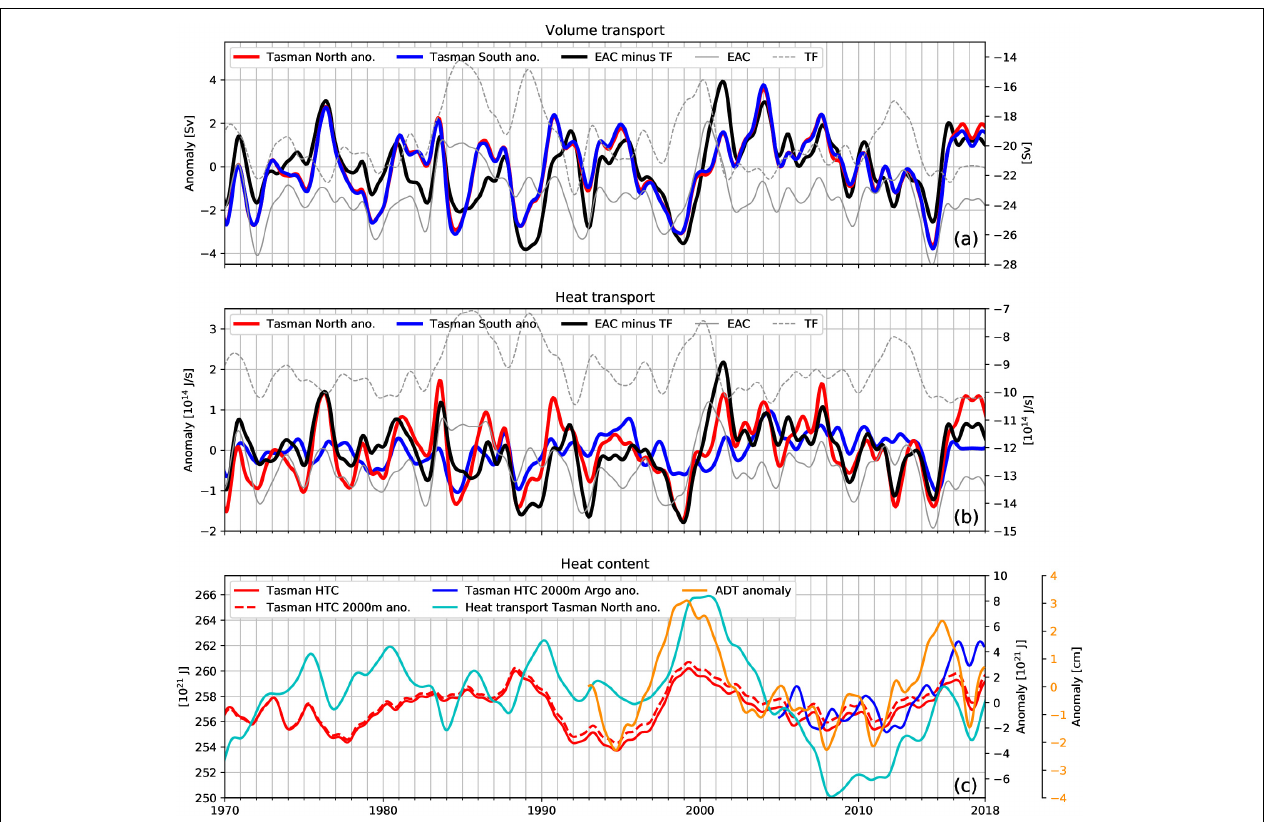
FIGURE 7 | Interannual filtered time series: (a) volume transport, (b) heat transport and (c) heat content (HTC). (a) Volume transport anomaly for the Tasman North (red) and Tasman South (blue) section and difference between EAC and Tasman Front (black). Transports of Tasman North and South reflect transports across the entire section. For transports of EAC and TF the cyan boxes in Figure 4 have been used as regional limits. For anomalies the time mean values from 1970 to 2017 have been used as reference. Net transports for EAC and TF are represented in thin gray lines and use the right hand y-scale. Note that, the sign for TF transport in (a,b) has been inverted. (b) Heat transport anomalies and net heat transports, as in (a) . (c) Tasman Sea heat content: full-depth (solid red line, left hand y-scale) and upper 2000 m anomalies (red dashed line, inner right hand y-scale). Heat content anomaly derived from the integrated Northern Tasman section heat transport (light blue line, linear de-trended, inner right hand y-scale). Argo-derived heat content anomaly (dark blue line, inner right hand y-scale) and absolute dynamic topography (ADT, orange line, linear de-trended, in cm and outer right hand